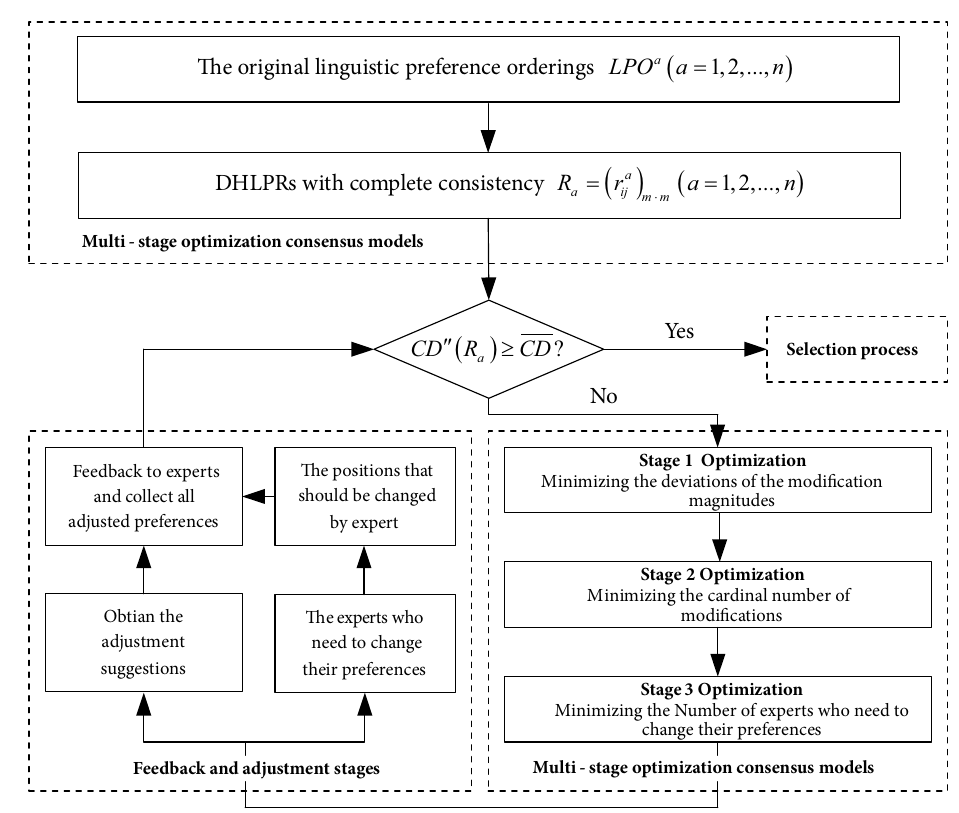
Figure 2. Multi-stage interactive group consensus optimization process with